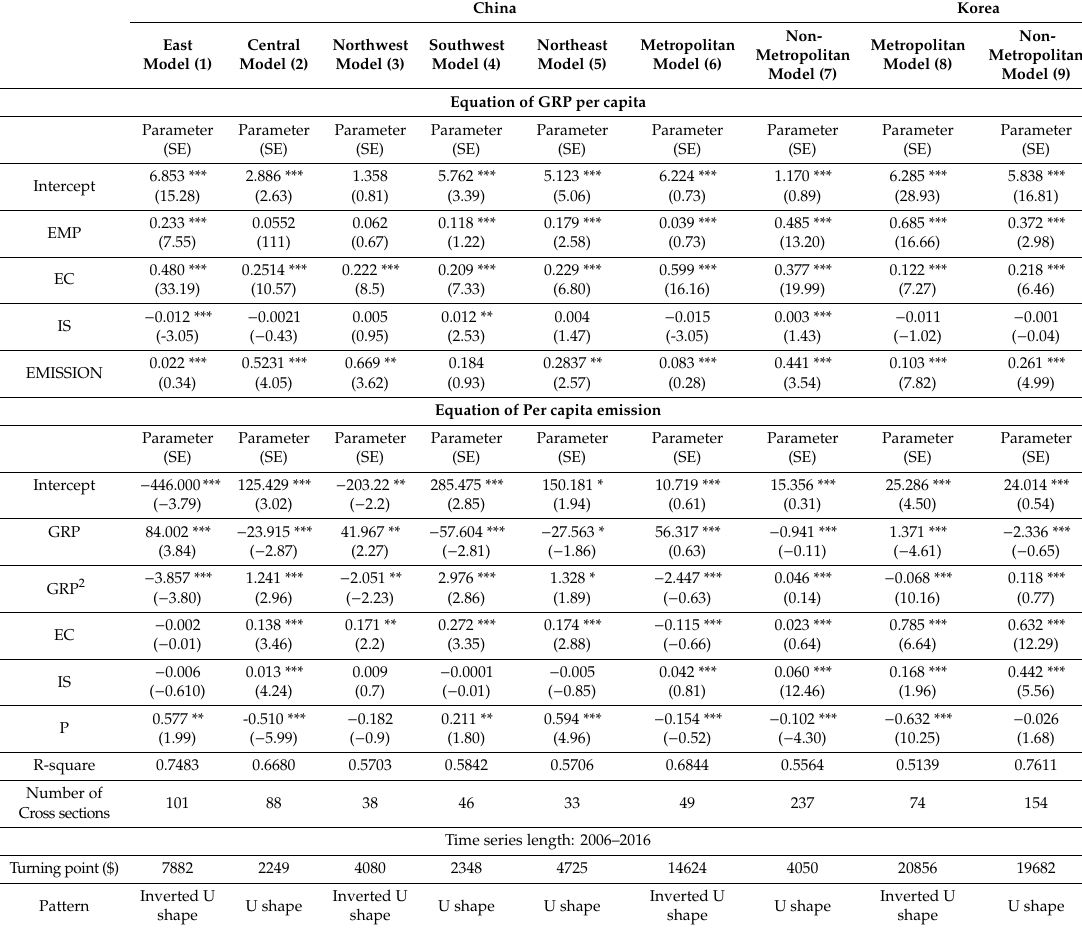
Table 3. Estimation Results of Simultaneous Equations by Three-Stages Least Squares